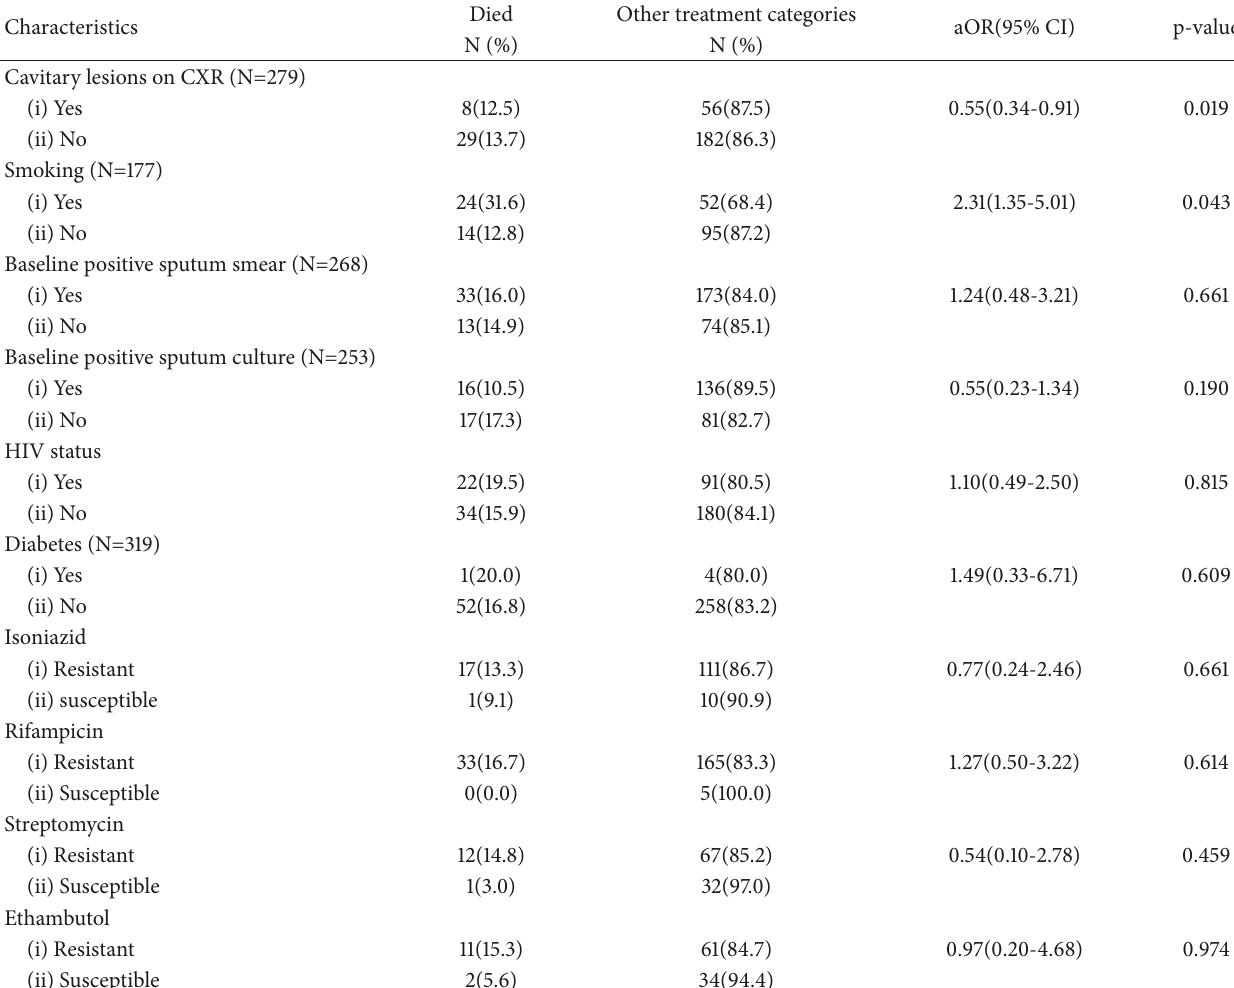
Table 7: Adjusted OR after multivariate analysis for predictors of treatment outcome of mortality/death (N=332).